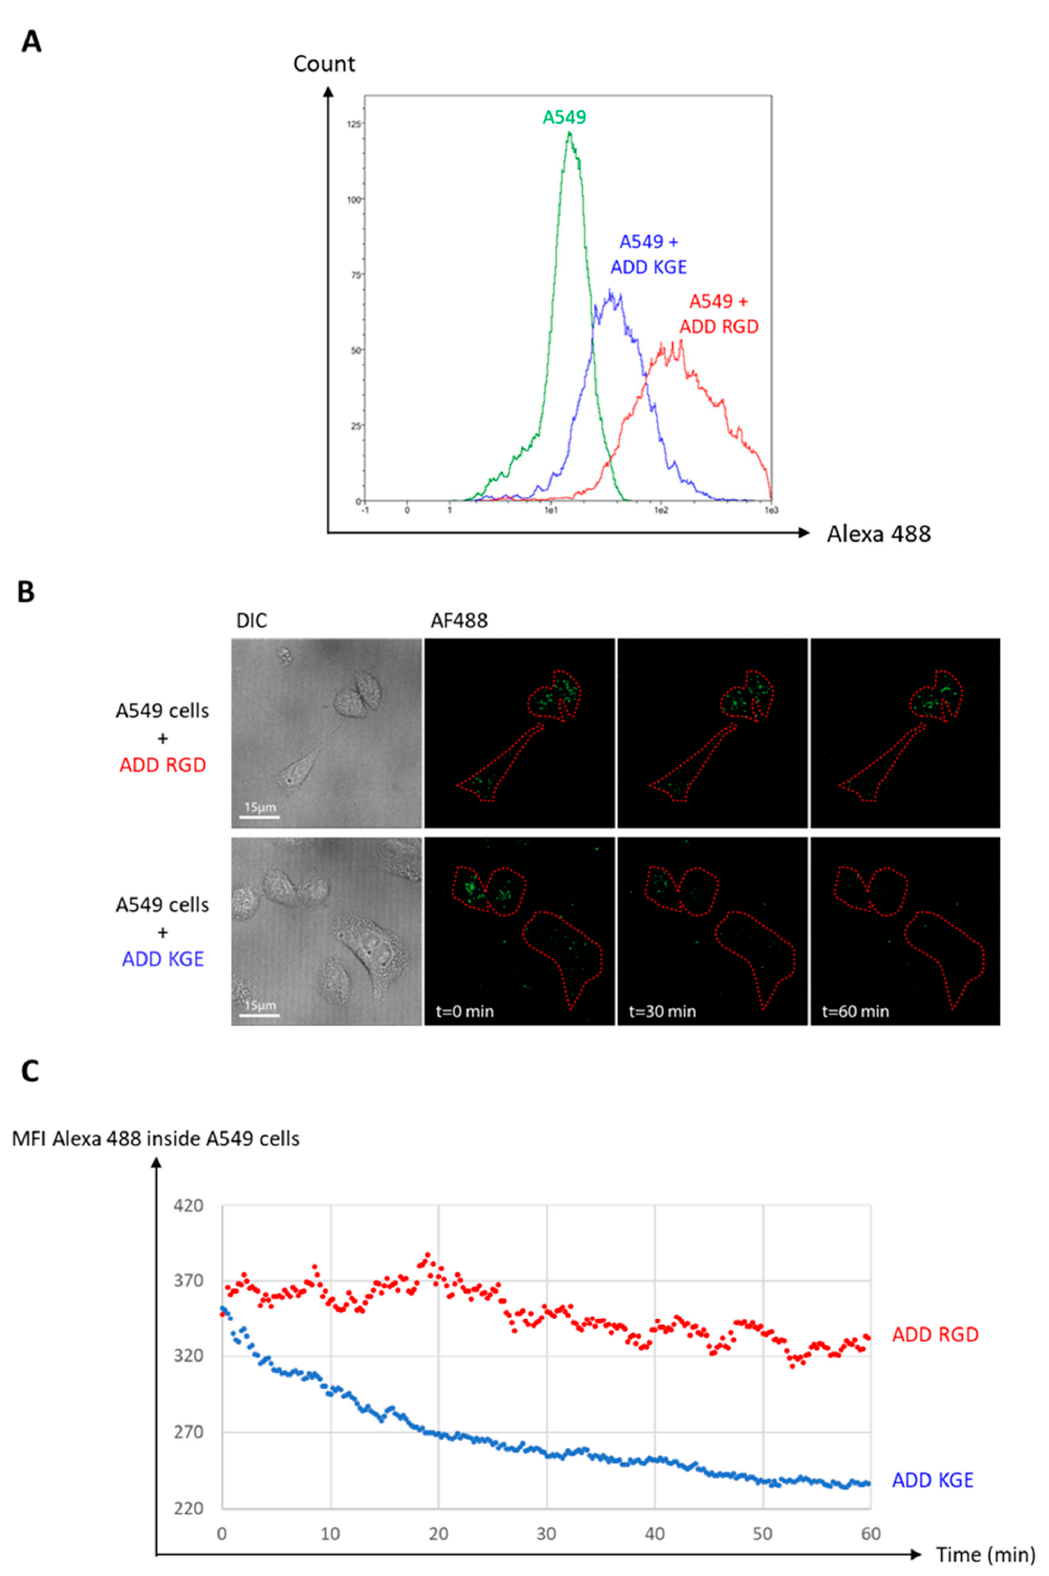
Figure 6. ADD KGE and ADD RGD internalization by lung epithelial cell line A549. ( A ) ADD KGE AF 488 and ADD RGD AF 488 internalization by lung epithelial cell line A549 evaluated by flow cytometry at t = 20 min. ( B ) Time lapse imaging by confocal microscopy of ADD KGE AF 488 and ADD RGD AF 488 internalization by lung epithelial cell line A549. ( C ) Mean Fluorescence Intensity (MFI) of ADD KGE AF 488 and ADD RGD AF 488 within cells over